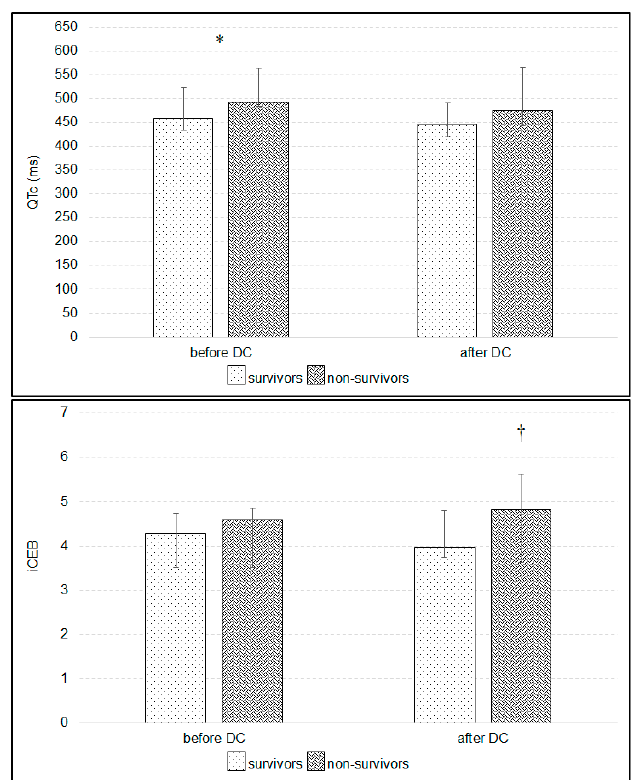
Figure 4. Changes in corrected QT interval (QTc) and the index of cardio-electrophysiological balance (iCEB) after compared to before decompressive craniectomy (DC) in patients who survived versus did not survive 28 days of treatment. * p < 0.05—differences between QTc before DC (Mann-Whitney U-test), and † p < 0.05—differences in iCEB after compared to before DC in patients who did not survive 28 days of treatment (Wilcoxon rank test). Table 3. Changes in STJ segment after compared to before decompressive craniectomy (DC) in patients who survived versus did not survive 28 days of treatment (Mann–Whitney U-test).